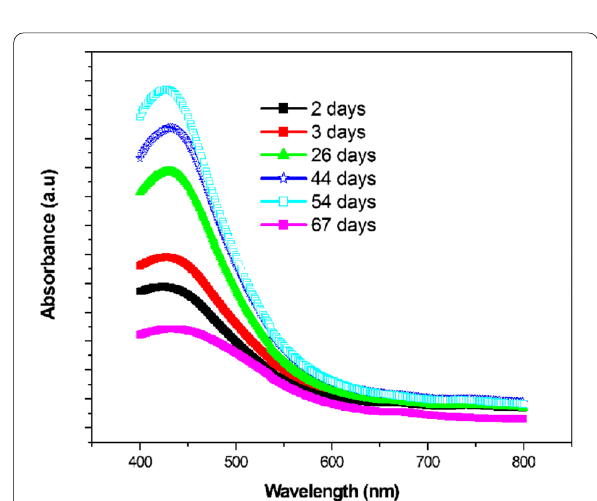
Fig. 4 Time dependence of optical absorbance of silver nano-particle colloidal solution at different time